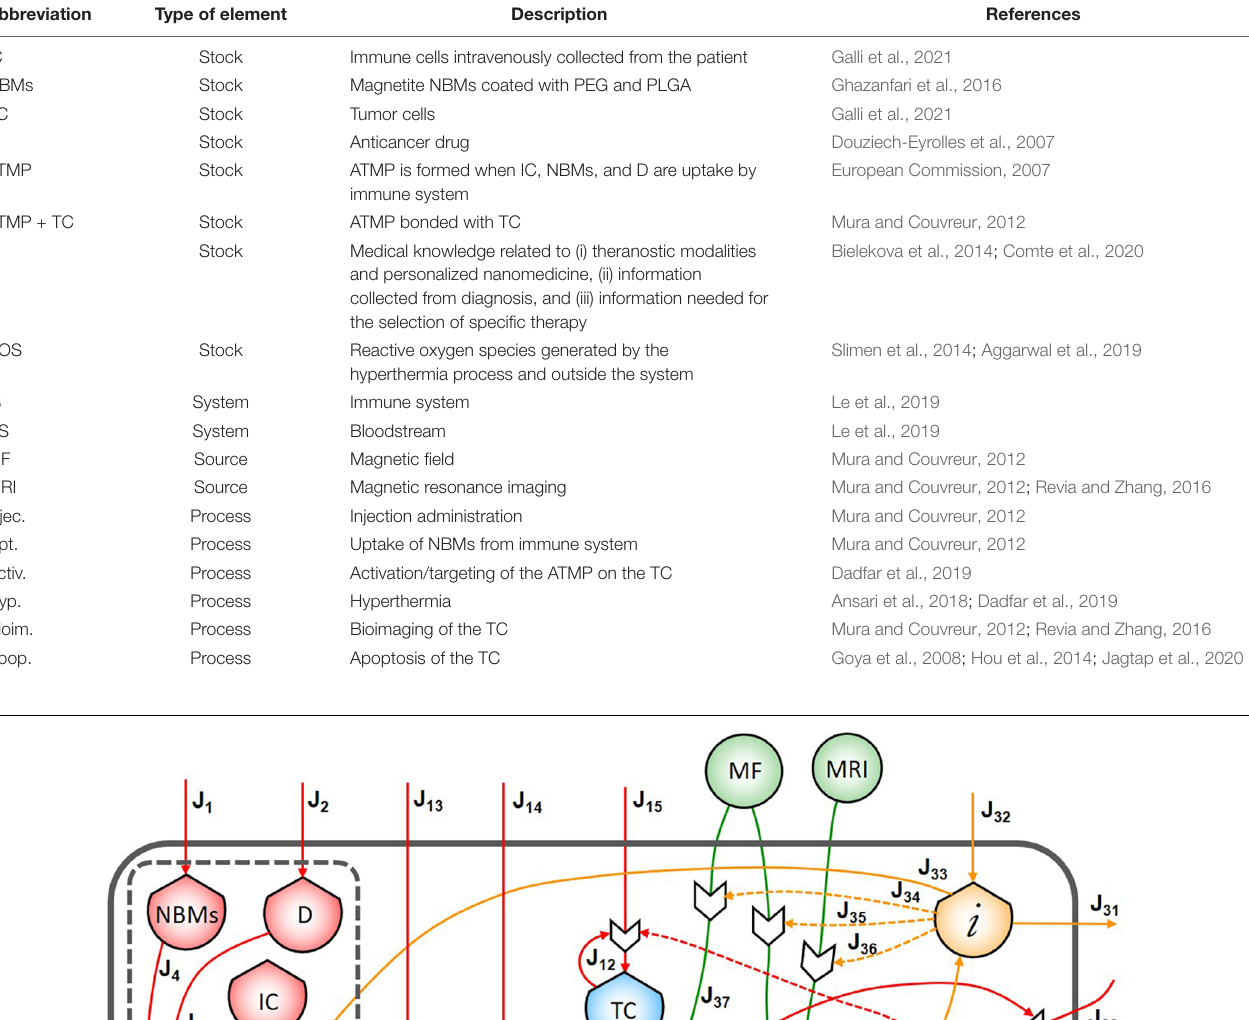
TABLE 1 | Description of the selected stocks, processes, sources, and systems and their abbreviations used in the final diagram.